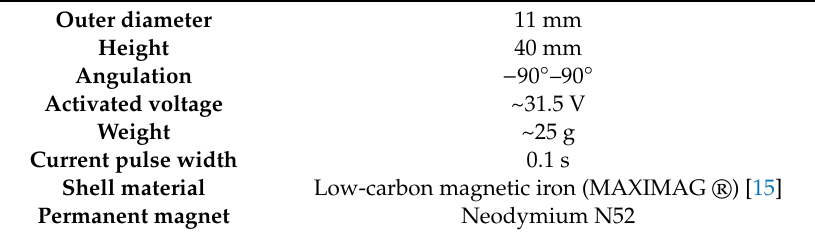
Table 1. Parameters of the developed hybrid actuator.